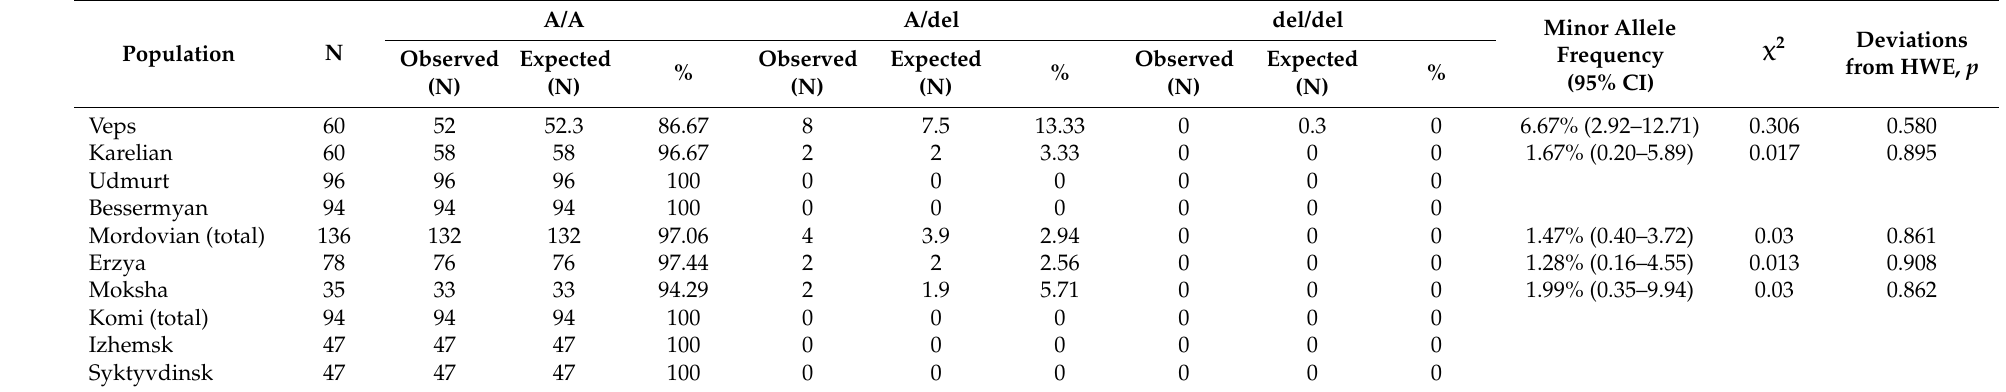
Table 8. Distribution of the rs4986774 genotypes of the CYP2D6 gene in the Finno-Permic populations of the Russian Federation.